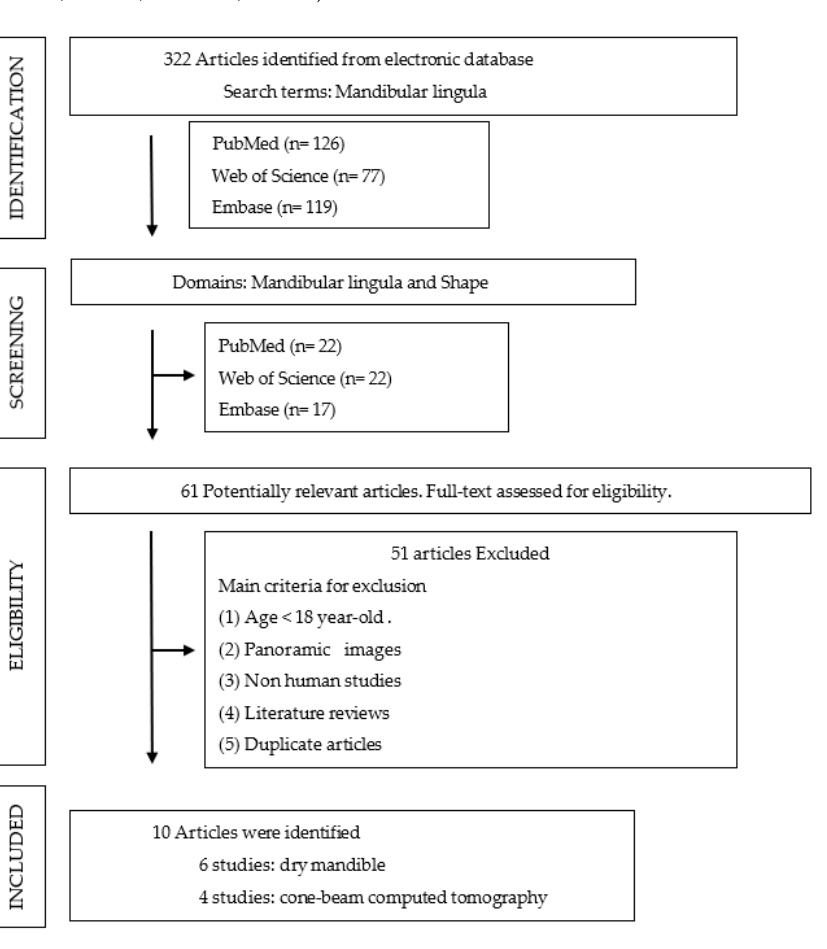
Figure 2. Process flow of article selection in the dry mandible group and CBCT group.